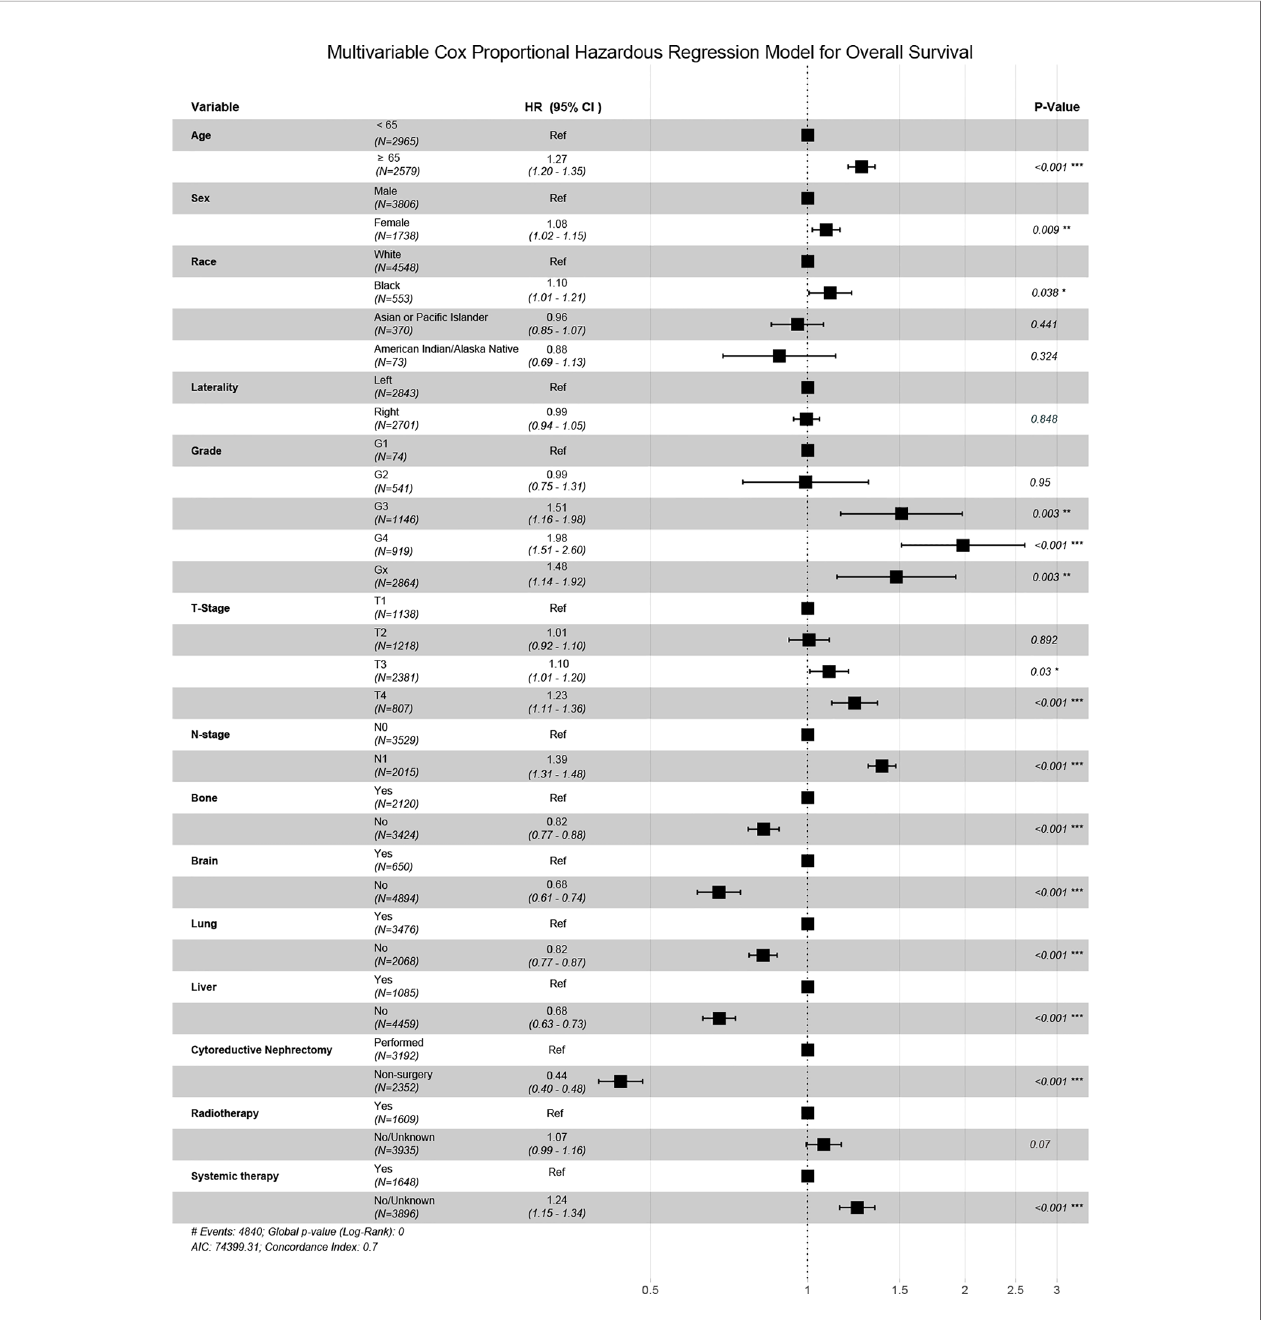
FIGURE 3 | The forest plot of multivariate Cox regression